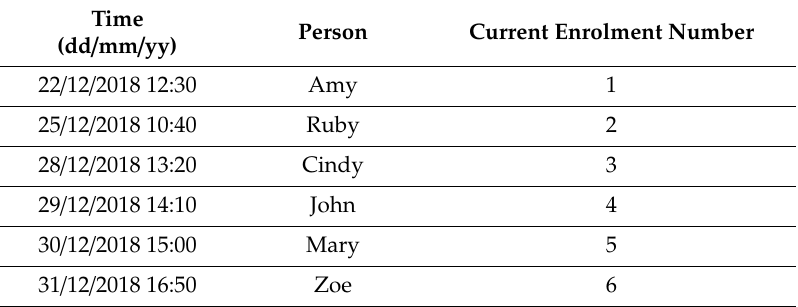
Table 5. An example of a data table in an event sourcing